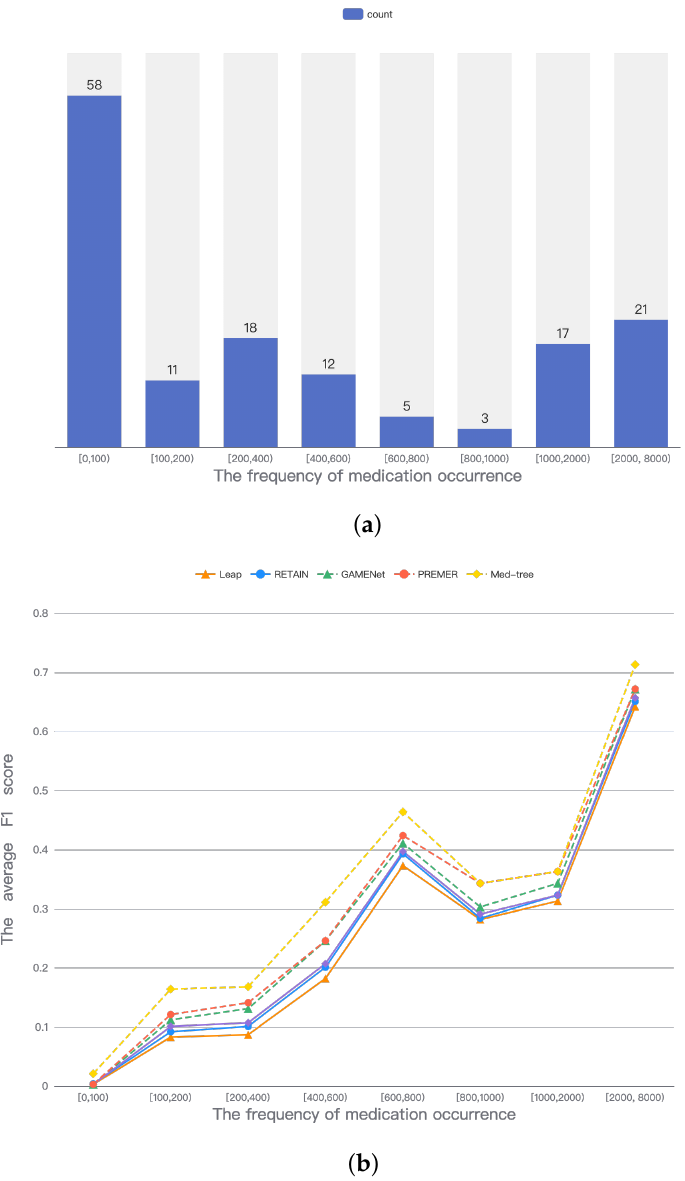
Figure 6. ( a ) is the total number of medications in different frequency ranges from MIMIC-III datasets and ( b ) is the comparison of the average F1 score recommended by different methods (Leap [43], RETAIN [21], GAMENet [22], PREMIER [44], and Med-tree) in different frequency ranges on MIMIC- III